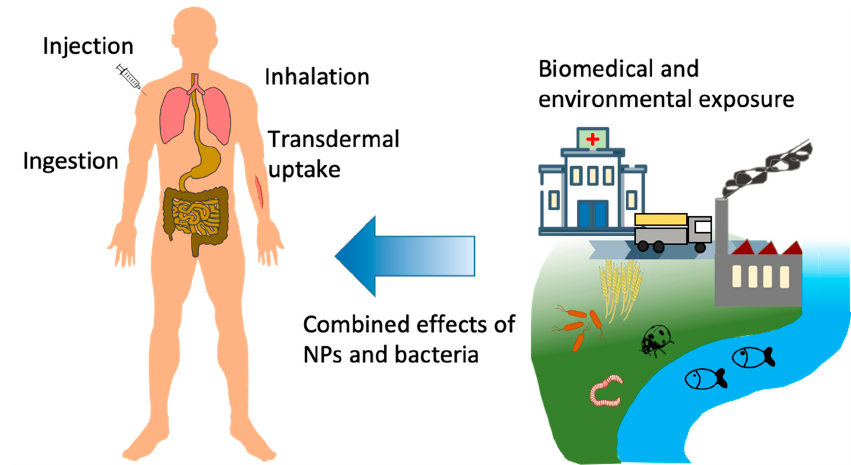
Figure 1. Overview of potential coexposure scenarios / interactions of nanoparticles (NPs) with ubiquitous bacteria / bacterial components, and main routes of uptake into the human